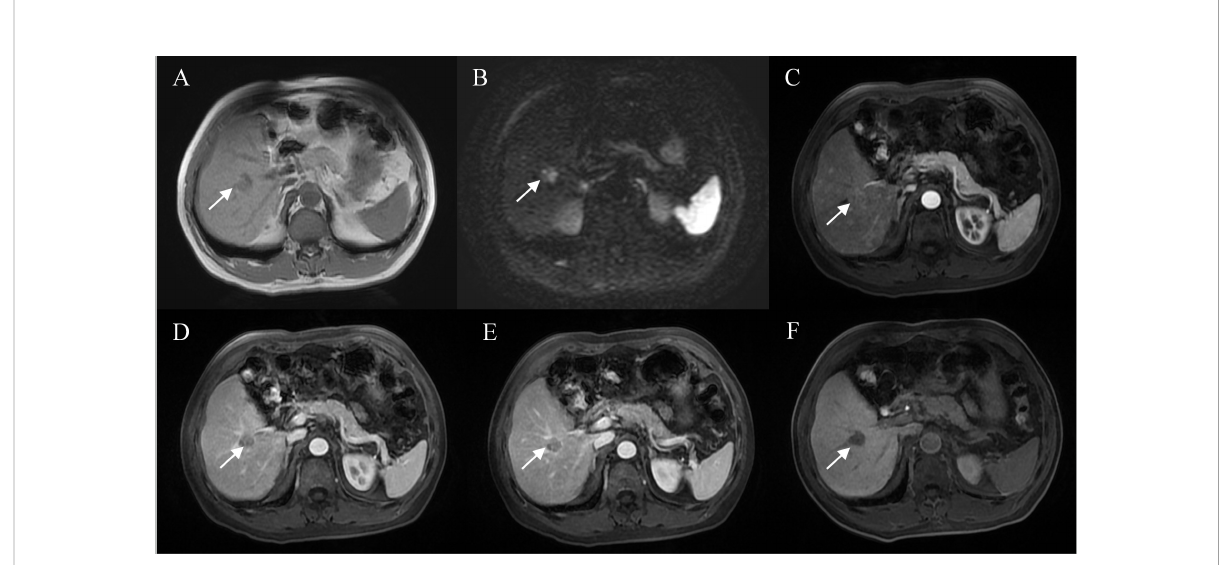
FIGURE 3 Representative images of MVI positive cases: A 60-year-old male with elevated AFP, Gd-BOPTA MRI detected a solid lesion in hepatic segment V (A) , restricted diffusion (B) , atypical enhancement pattern without “ wash-in ” (C – E) , incomplete capsule enhancement on portal venous phase and transitional phase images (D, E) , and homogeneous HBP hypointensity (F) .